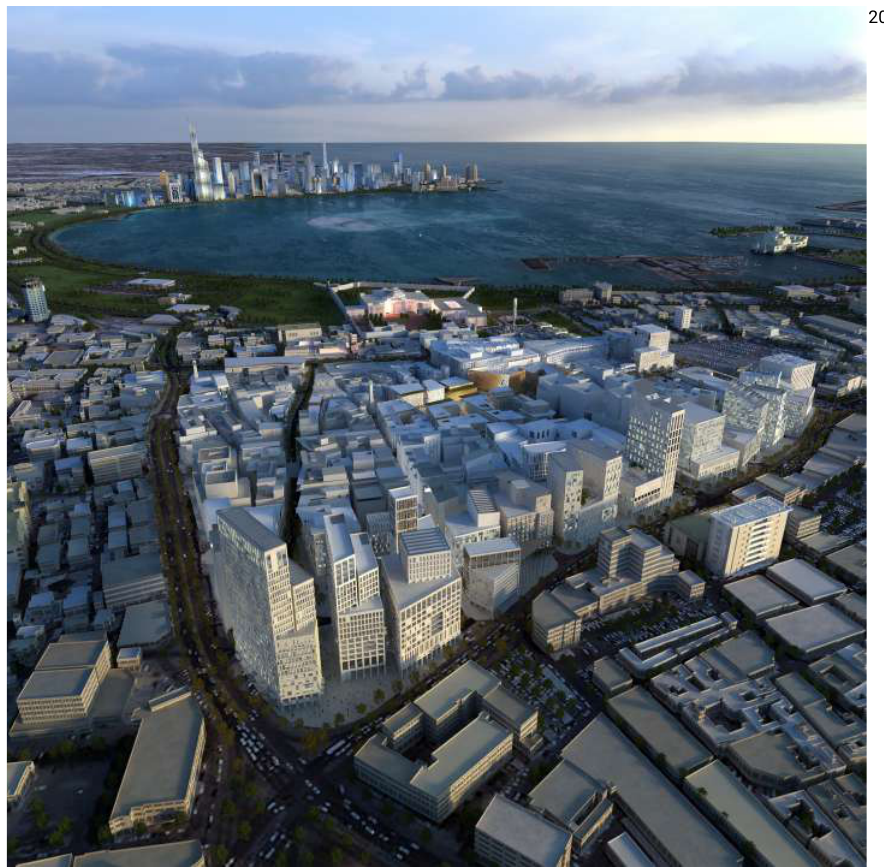
Nearly the same perspective as fig. 19, a computer rendering of Msheireb Downtown Doha, with the West Bay skyline in the distance (Source: Msheireb Properties,